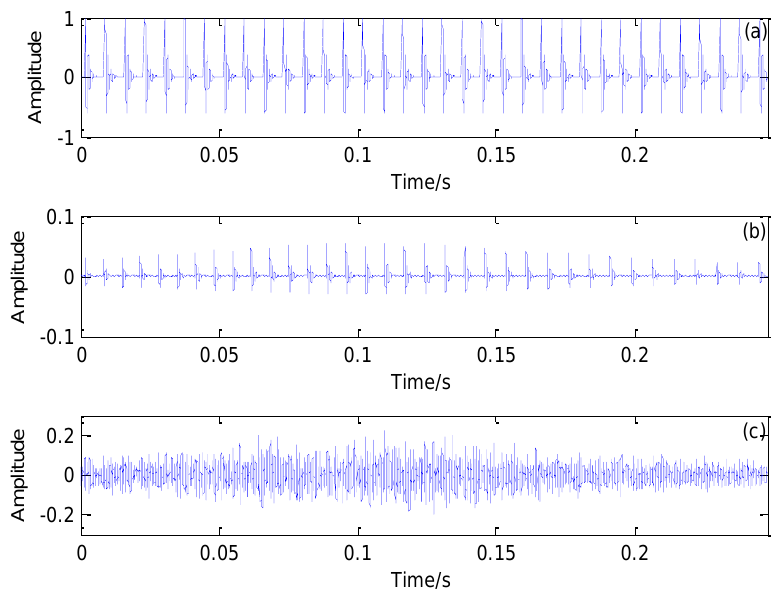
Figure 16. Results for a loading of 1 t obtained using the proposed method: ( a ) the optimal periodical transient model; ( b ) the optimal Doppler transient model and ( c ) the outer race fault